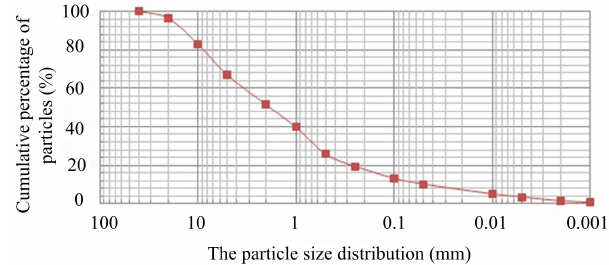
Figure 12. The grain grading graph of the Guojuanyan